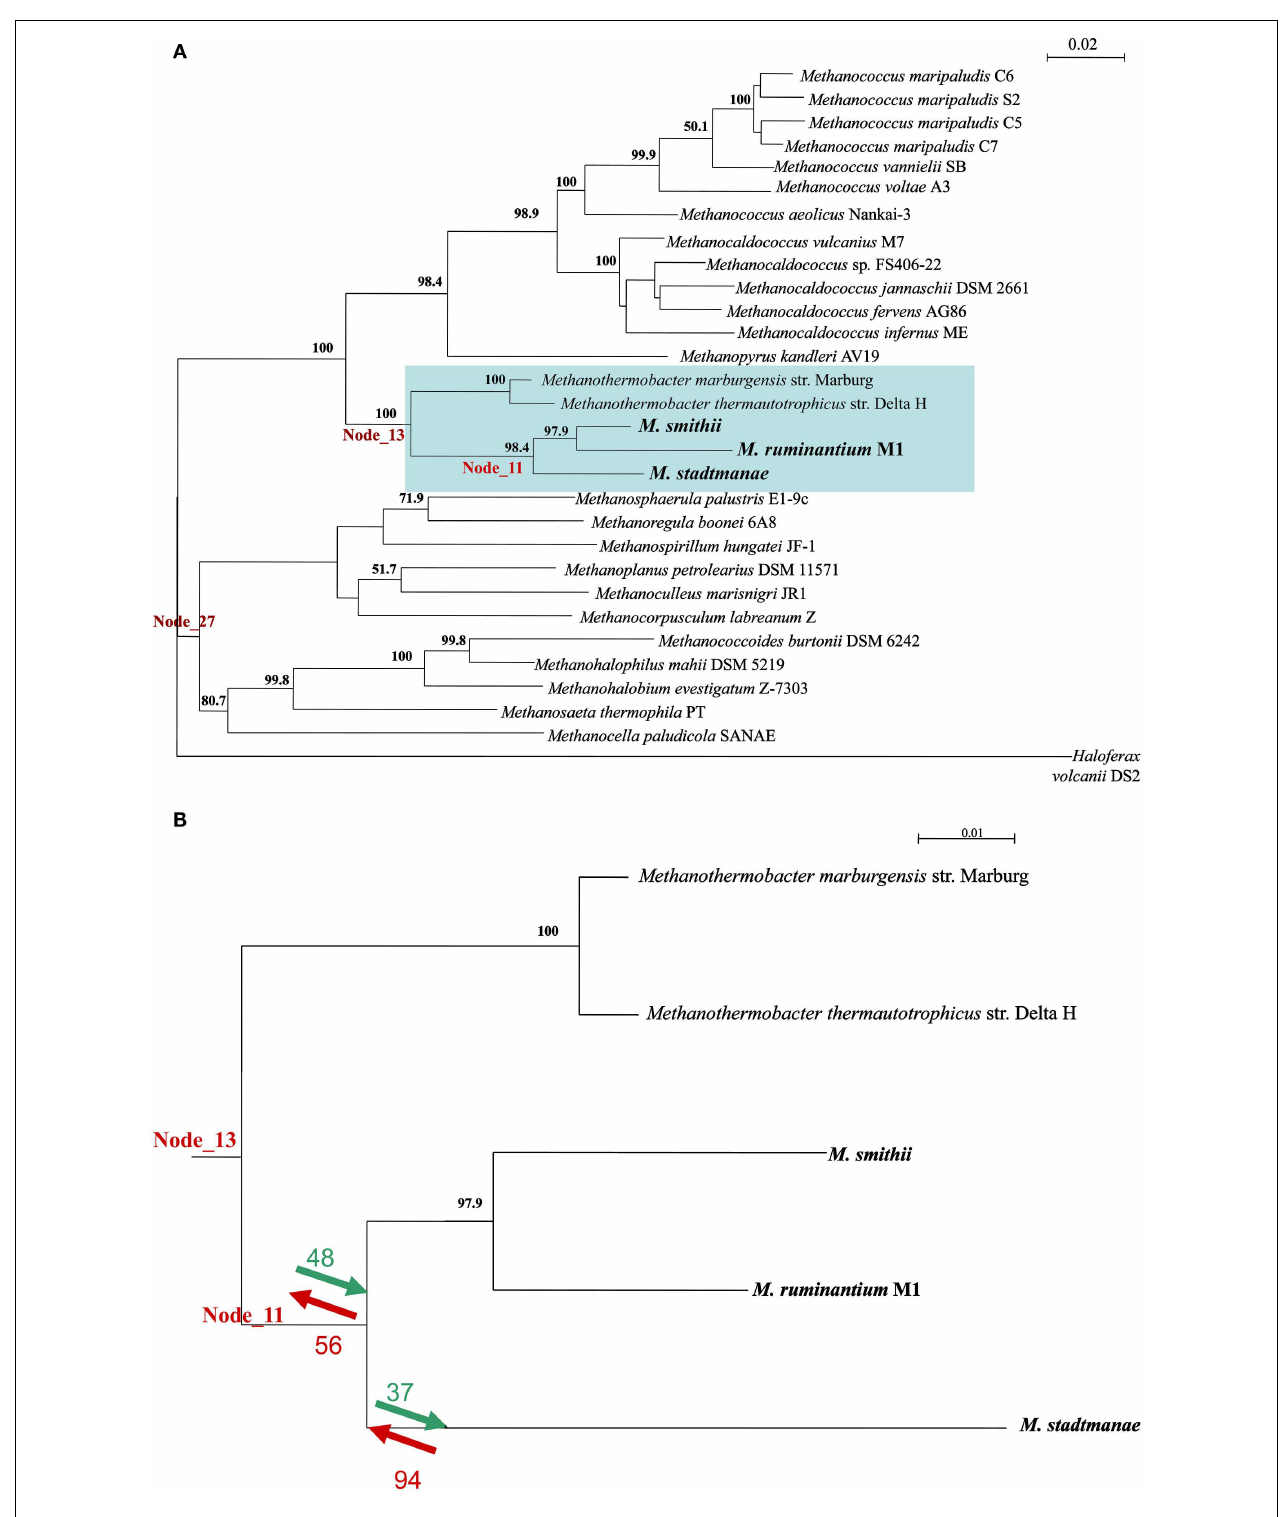
either gained (green) or lost (red) upon their divergence, and the divergence of M. stadtmanae and the two Methanobrevibacter species. A complete list of species can be found inTable S4 in Supplementary